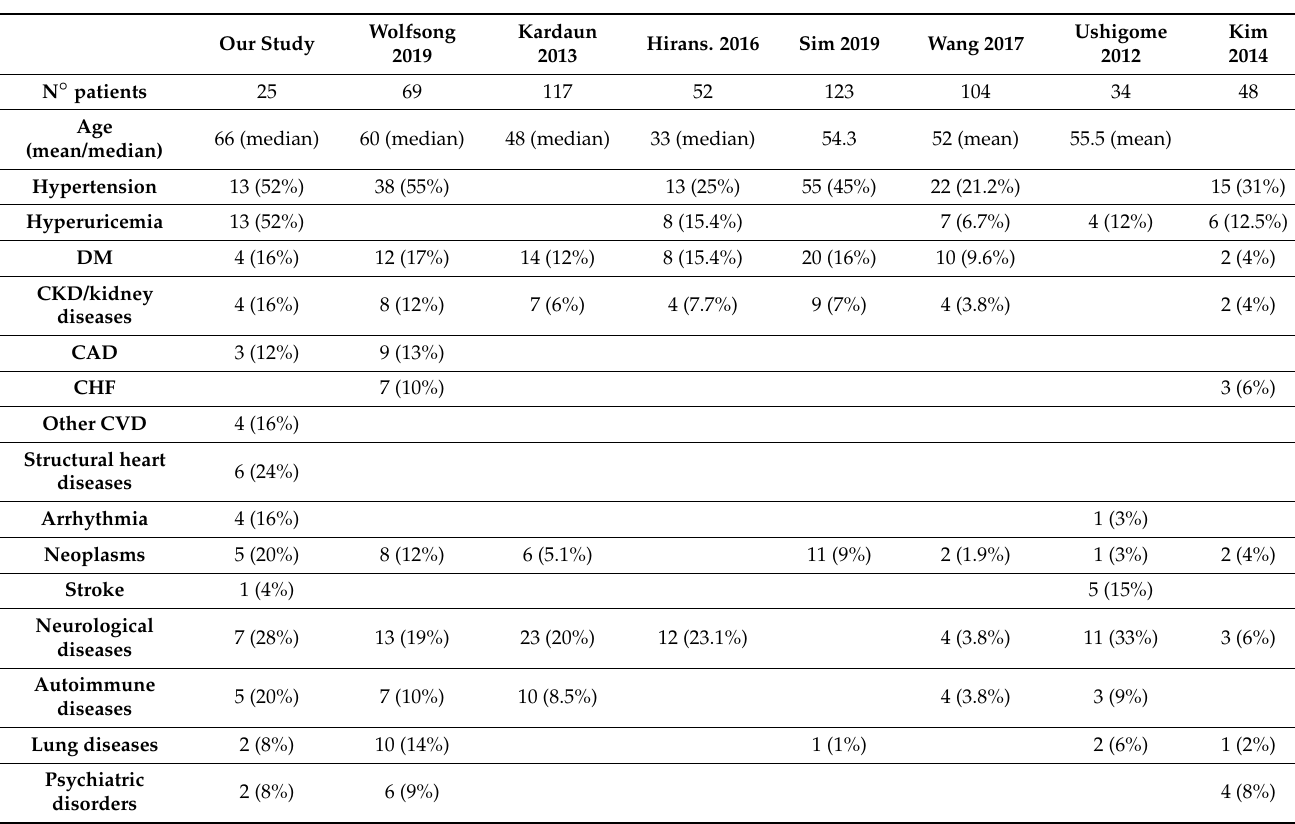
Figure 5. Frequency (%) of comorbidities found in our study population. Table 4. Comorbidities found in our study compared with other case